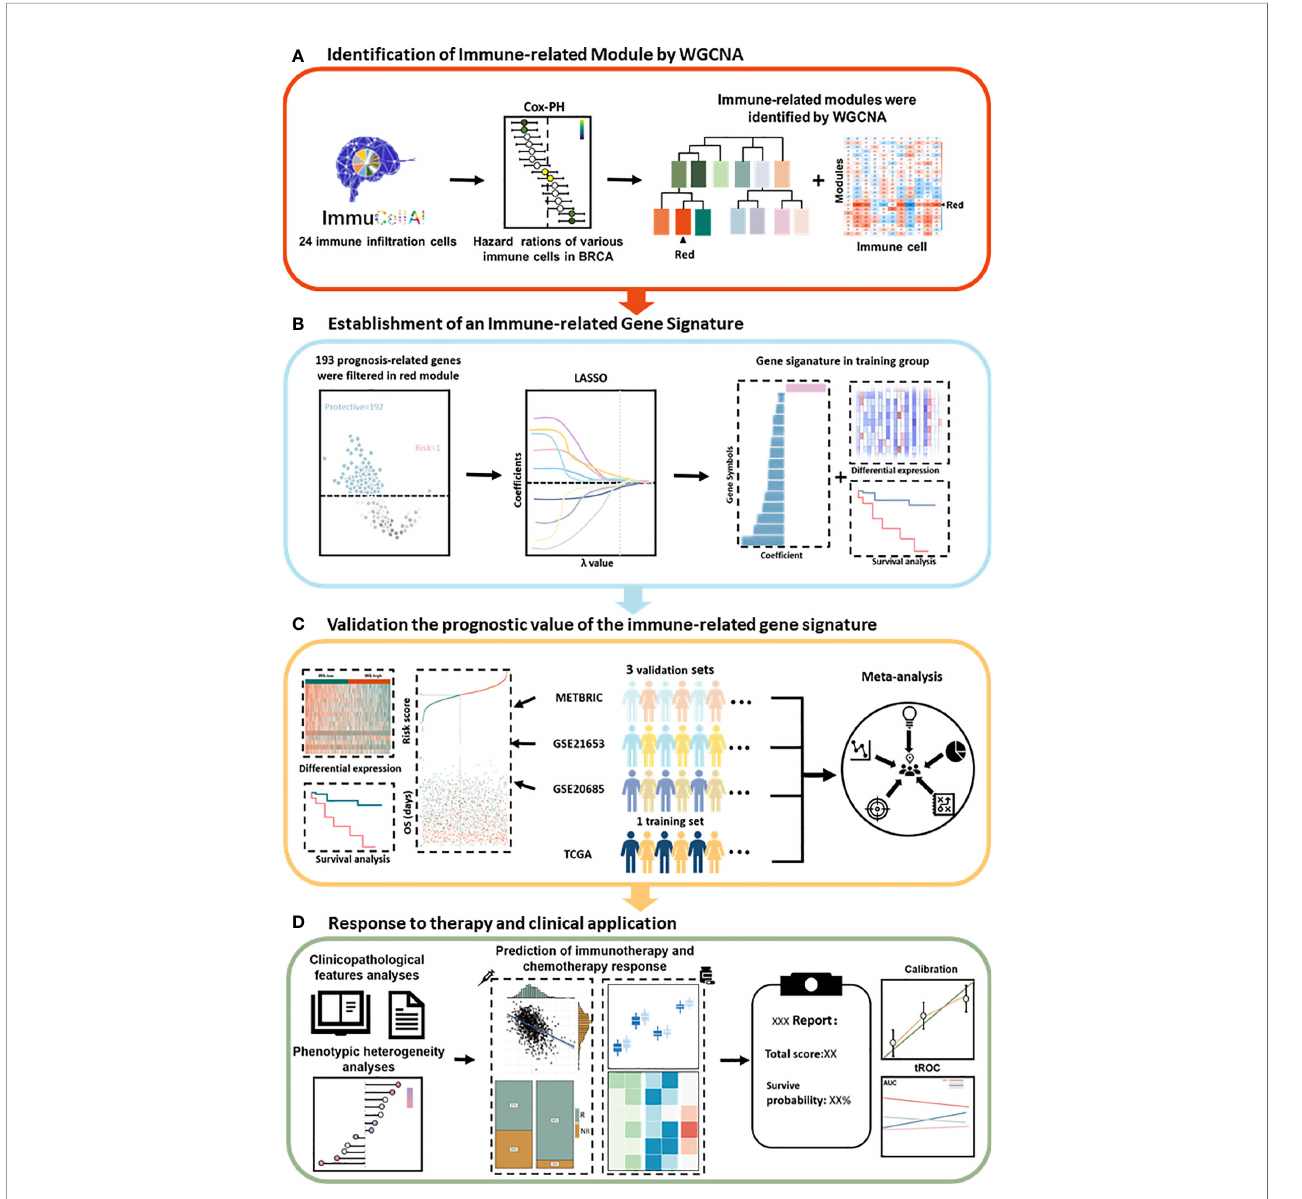
FIGURE 1 | Schematic diagram of the study design. (A) The red module was identi fi ed as the immune-related module in breast cancer by WGCNA. (B) Combined methods were used to establish a robust immune-related gene signature for prognosis. (C) The prognostic value of the gene signature was validated in different cohorts. (D) Clinical features and application of the IRS. Cox-PH, Cox proportional hazards; LASSO, least absolute shrinkage and selection operator; tROC, time- dependent receiver operating characteristic; WGCNA, weighted gene coexpression network